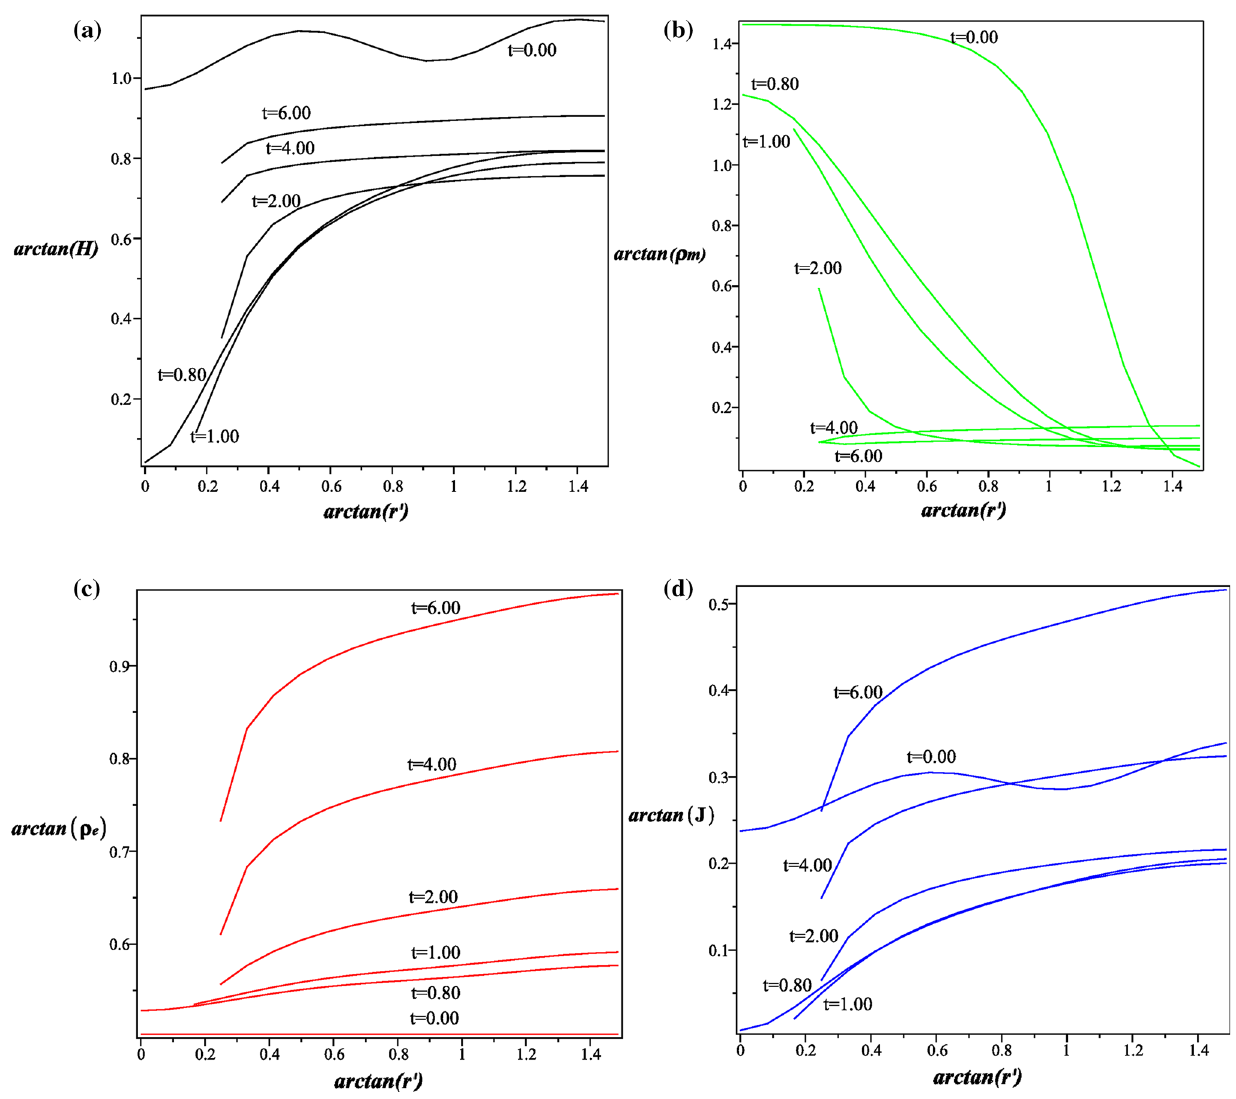
Fig. 6 Local profiles of different scalar functions for the configuration with initial conditions given by (31) and w = − 1 . 15, α = 0 . 1 at different instants of time. a scalar H . b scalar ρ ( m ) . c scalar ρ ( e ) . d scalar J . Refer to the text for a detailed discussion of the